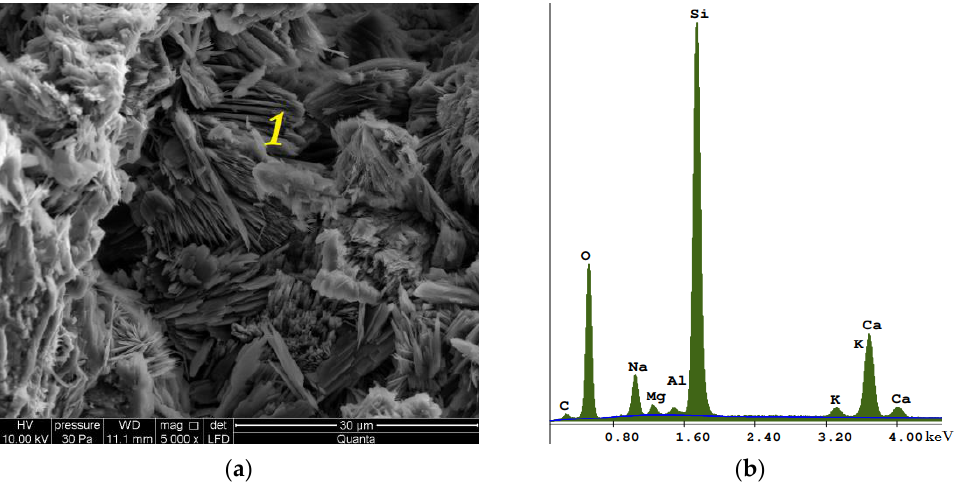
Figure 15. Photograph of the microstructure of silicate brick modified with glass sand and taken with the use of SEM; ( a ) gyrolite/natrolite—the figure shows systems in the form of flakes (1), thin sheets of ice that form into clusters, similar to gyrolite (1) or natrolite. ( b ) EDS spectrum glass sand modified silicate brick in point 1, visible Na as a component of glass sand and an element responsible for the crystallization toward gyrolite or